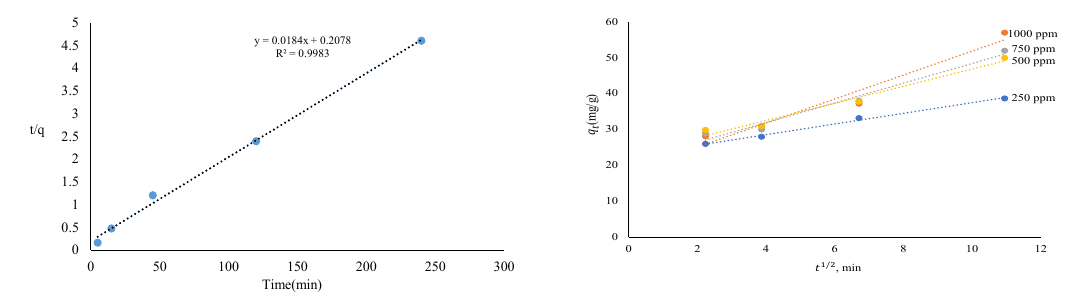
Fig. 7. Pseudo second-order kinetics of Cd2+ sorption Fig. 8. Morris–Weber kinetic plots for the sorption of the ontonnatural zeolite. sorption of Cd2+ ions from aqueous solutions. Table 3. Internal diffusion rate constant for the sorption Cd2+ ions onto natural Table 3 Internal diffusion rate constant for the sorption Cd 2+ ions onto natural zeolite at different initial concentration. zeolite at different initial Initial k ad (mg/g min 1/2 ) concentration(ppm)